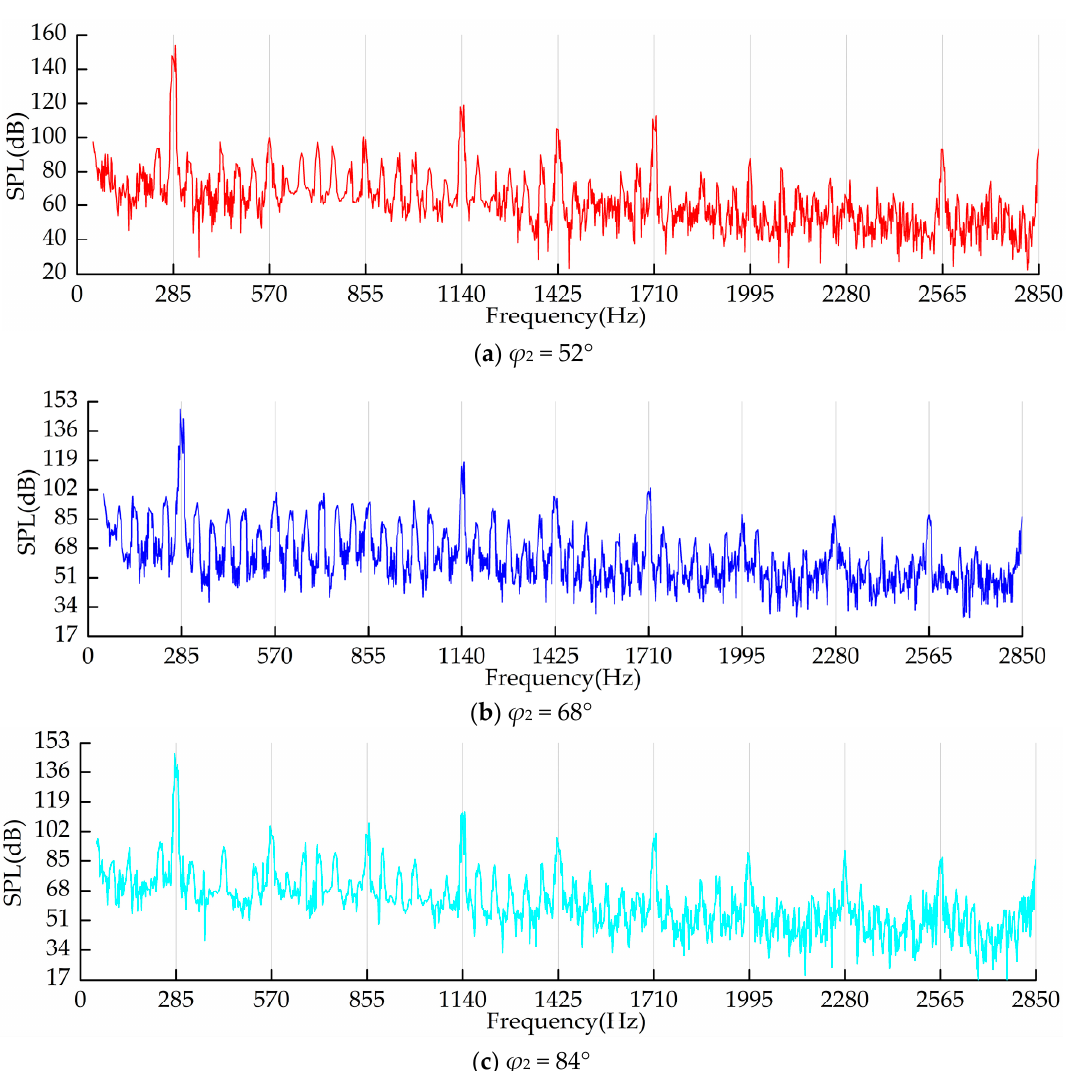
Figure 16. Frequency response curves of the hydroacoustic SPL inside the impeller with different wrap